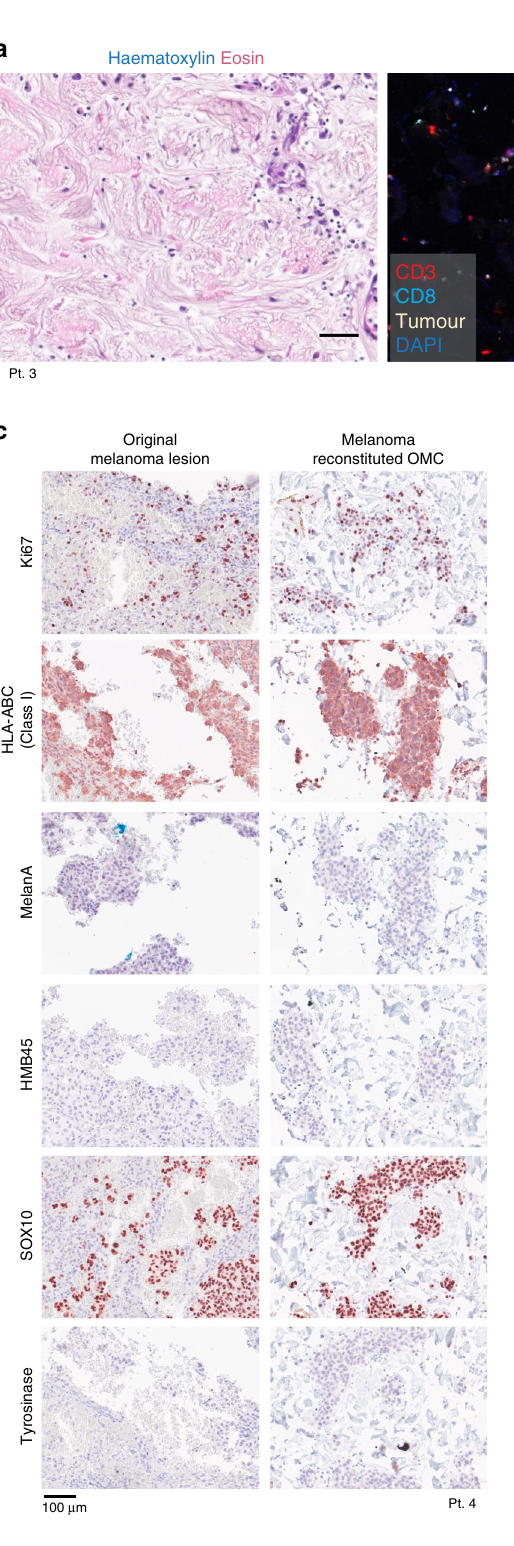
Isolation of human blood immune cells . Peripheral blood mononuclear cells (PBMCs) were isolated from buffy coats obtained from healthy volunteers (San- quin) and puri fi ed via centrifugation over a Ficoll density gradient (Axis-Shield) in SepMate tubes (Stemcell technologies). cDC2s (CD1c + ) cells were puri fi ed with magnetic cell sorting (MACS) from healthy donor PBMCs using the CD1c (BDCA1) DC isolation kit (Miltenyi Biotec). To obtain a highly puri fi ed CD1c + CD14 − population, a pre-depletion step of monocytes using CD14-MACS microbeads (Miltenyi Biotec) was included in the original manufacturer ’ s protocol. DC purity was assessed by staining with primary directly labelled antibodies: anti-